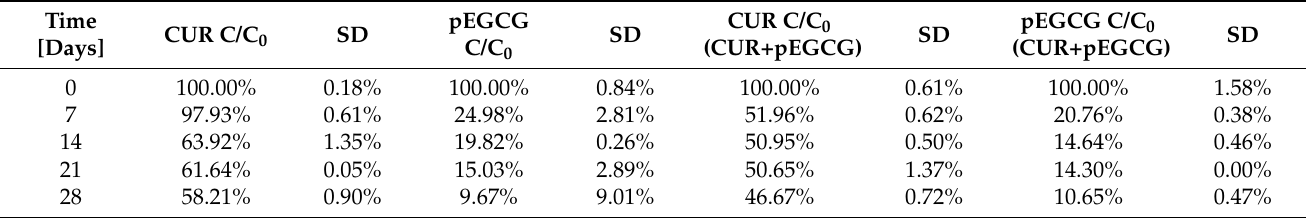
Table 4. Changes in the concentration of CUR and pEGCG in liposomal nanoformulations in the stability study at refrigerator temperature (4–8 ◦